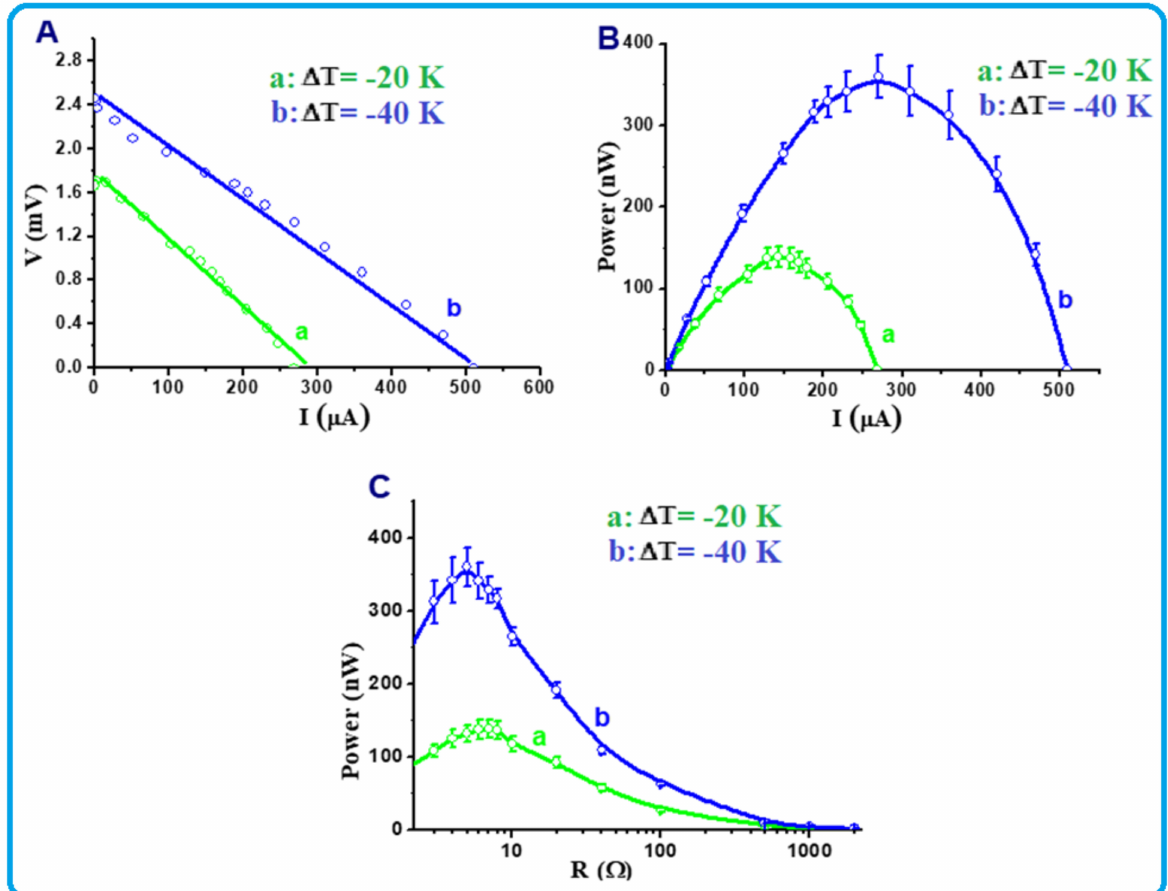
Figure 9. ( A – C ) Below RT thermoelectric power characteristics of the TOS single-leg module at ∆ T = − 20 K and − 40 K (for ∆ T = − 20 K: T T 2 = 233